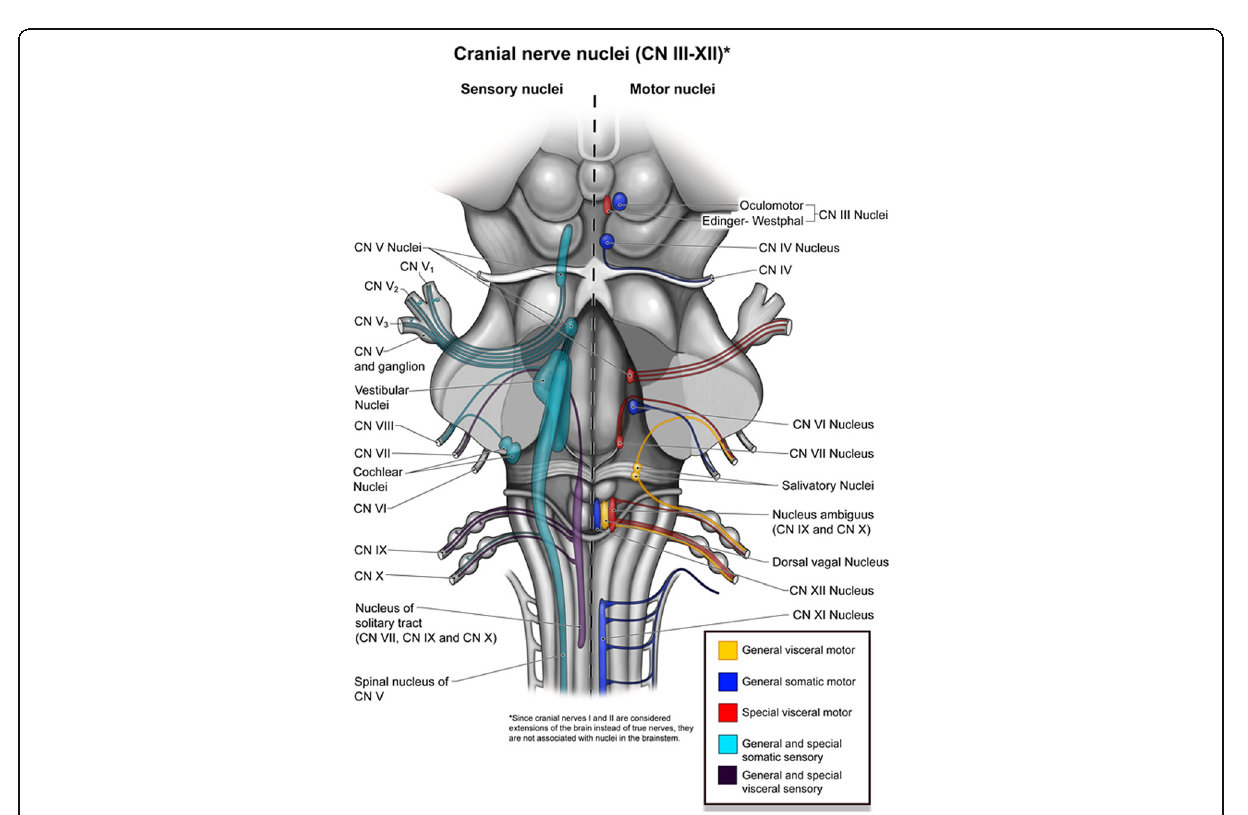
Fig. 2 Representative illustration of the brainstem demonstrating the normal configuration of the cranial nerves and their associated nuclei.